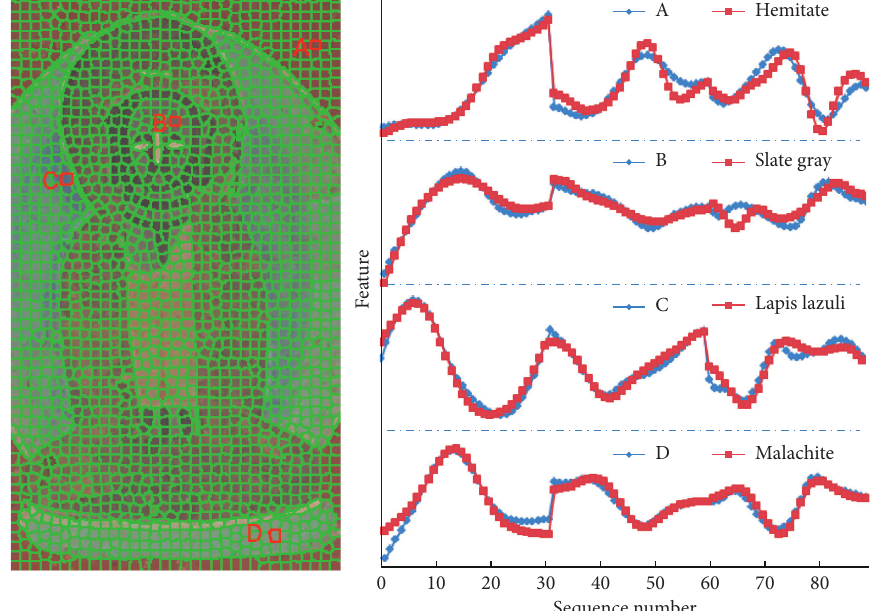
Figure 4: Pigment identification results based on visible spectral